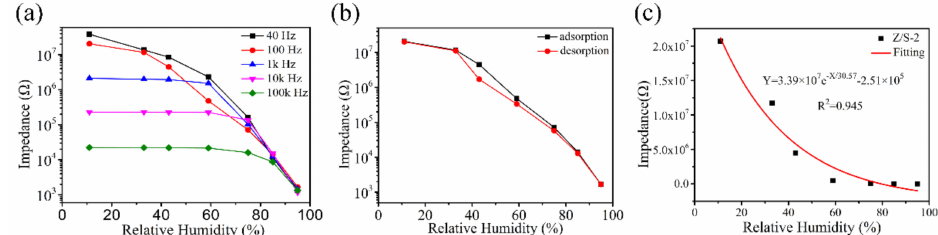
Figure 10. ( a ) Impedance changes of Z/S-2 humidity sensor at different operating frequencies, ( b ) hysteresis loop, and ( c ) response function of the Z/S-2 humidity